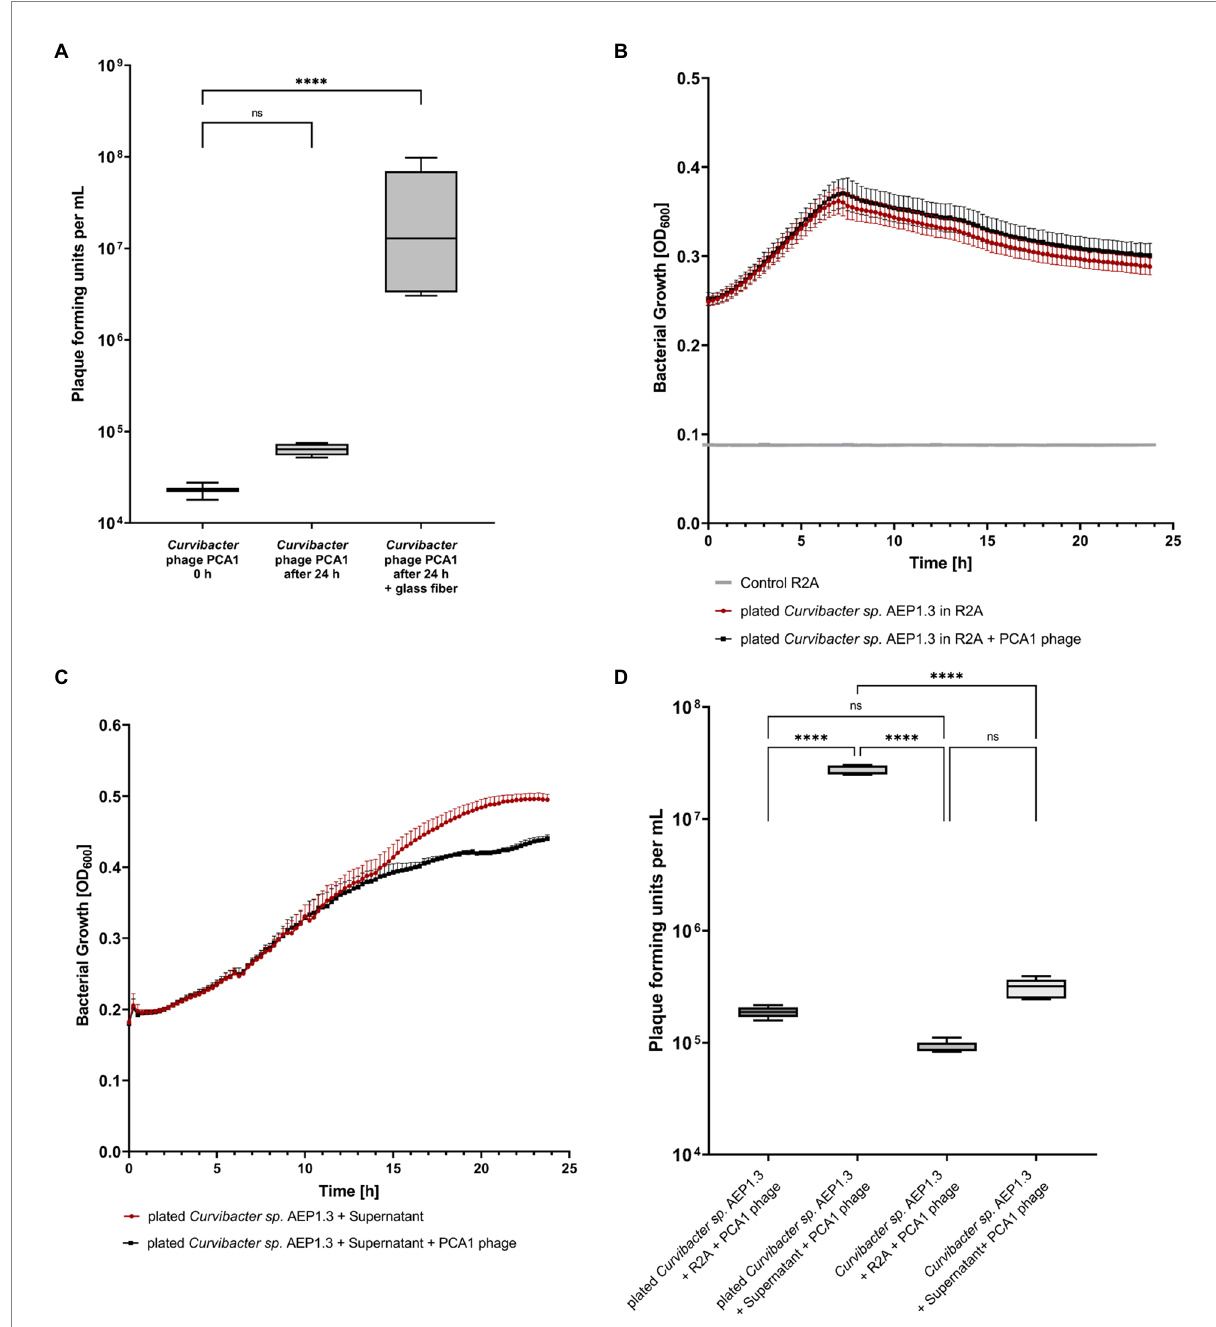
FIGURE 3 (A) Box-Plot diagram displaying plaque forming unit counts of Curvibacter phage PCA1 in liquid culture and liquid culture filled with glass fiber. (B) Growth curves of Curvibacter sp. AEP1.3 with and without Curvibacter phage PCA1. Bacteria were grown on solid medium and transferred into liquid culture, where growth was determined via optical density (OD) at 600 nm ( n = 5). (C) Growth curves showing Curvibacter sp. AEP1.3 transferred from solid medium to liquid culture, measured at OD 600 . Supernatant from plated Curvibacter sp. AEP1.3 was added to cultures alongside PCA1 phage. ( n = 4). (D) Plaque forming unit counts of Curvibacter phage PCA1 in Curvibacter sp. AEP1.3 cultures. Treatments included addition of supernatant or R2A to bacteria in liquid culture or bacteria transferred from solid agar plates to liquid culture ( n = 5). “****” indicates adjusted p -value beneath 0.0001 in Tukey’s multiple comparisons test.